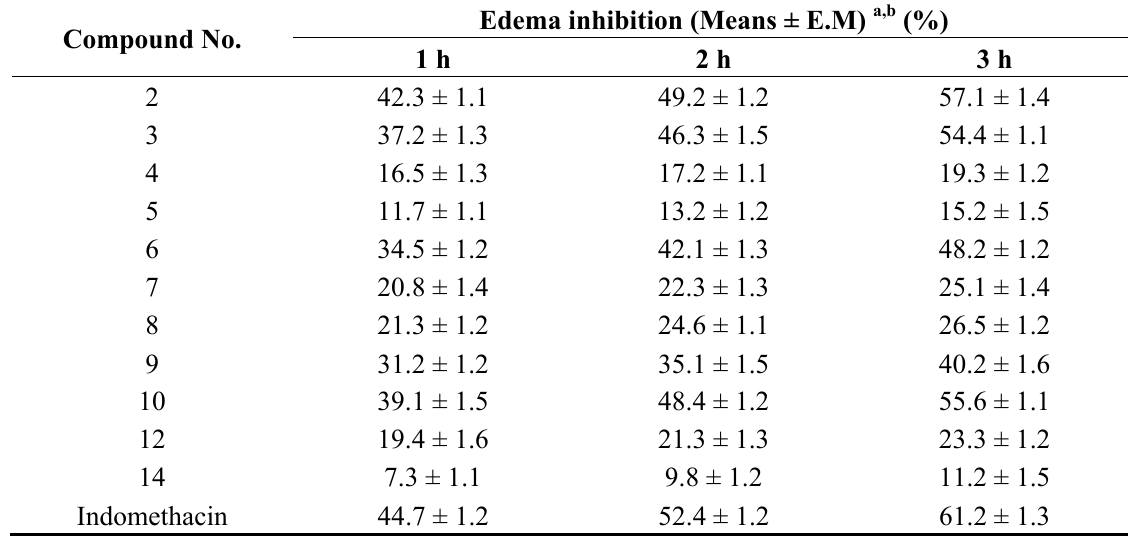
Table 1. Anti-inflammatory activity of the synthesized compounds. Compound No.